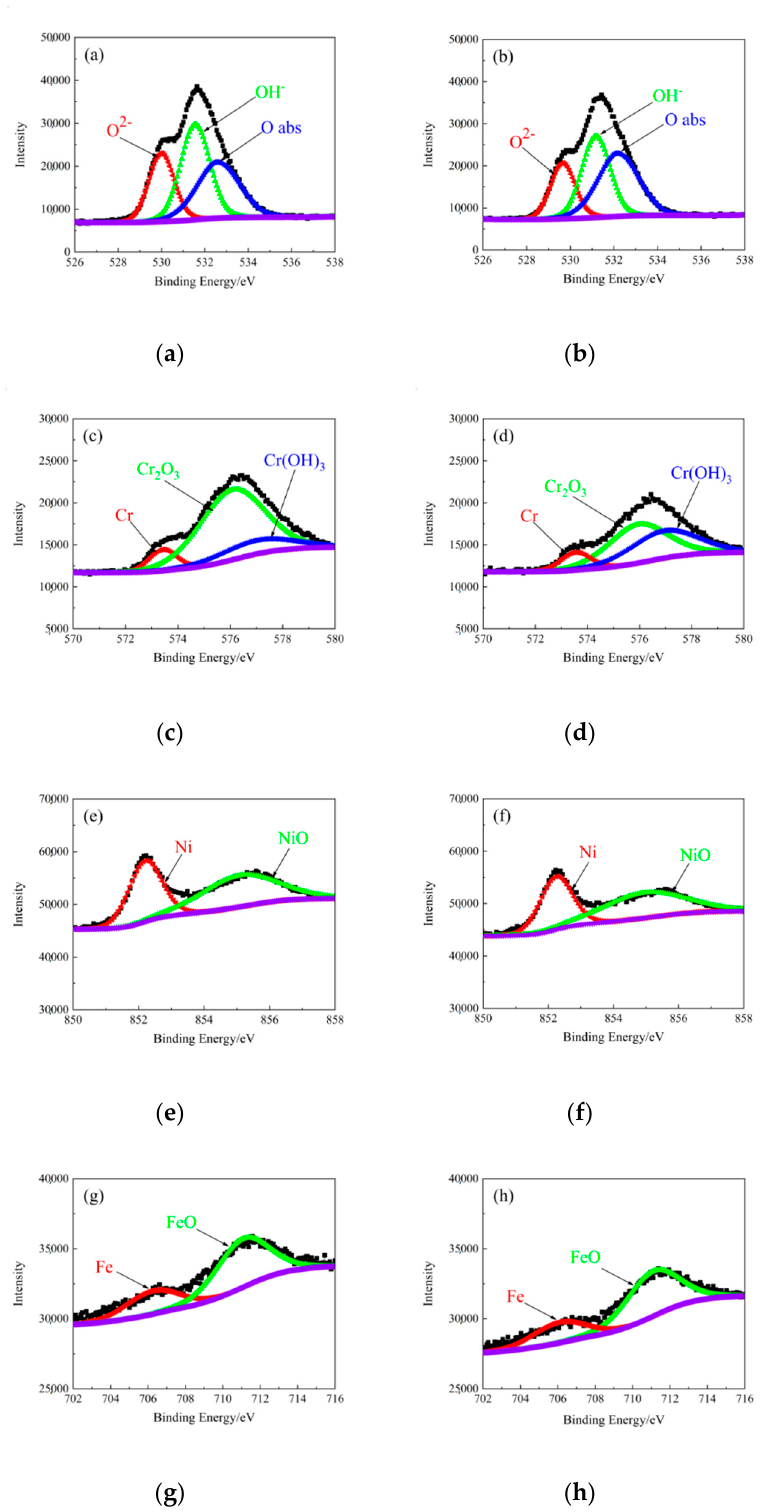
Figure 8. XPS spectra of ( a,b ) O1s, ( c,d ) Cr 2p 3/2 , ( e,f ) Ni 2p 3/2 and ( g,h ) Fe 2p 3/2 of alloy 690 ( a,c,e,g ) before and ( b,d,f,h ) after USRT with immersion in the secondary side environment.